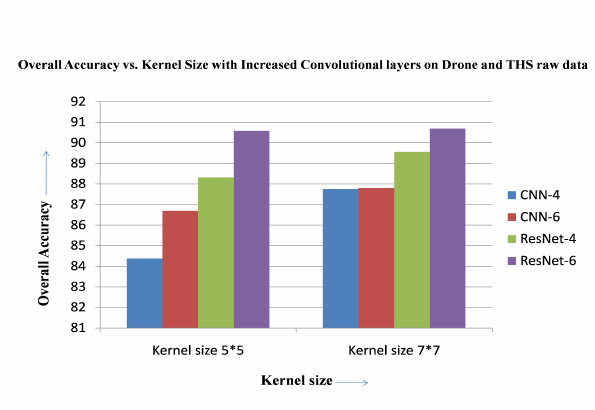
Figure 8: Example of CNN and ResNet models. CNN-4(left) CNN-10(middle)and ResNet-10(right) 6. RESULT AND DISCUSSION- PART II: CONVOLUTIONAL NEURAL NETWORK (CNN) MODEL AND ARCHITECTURE